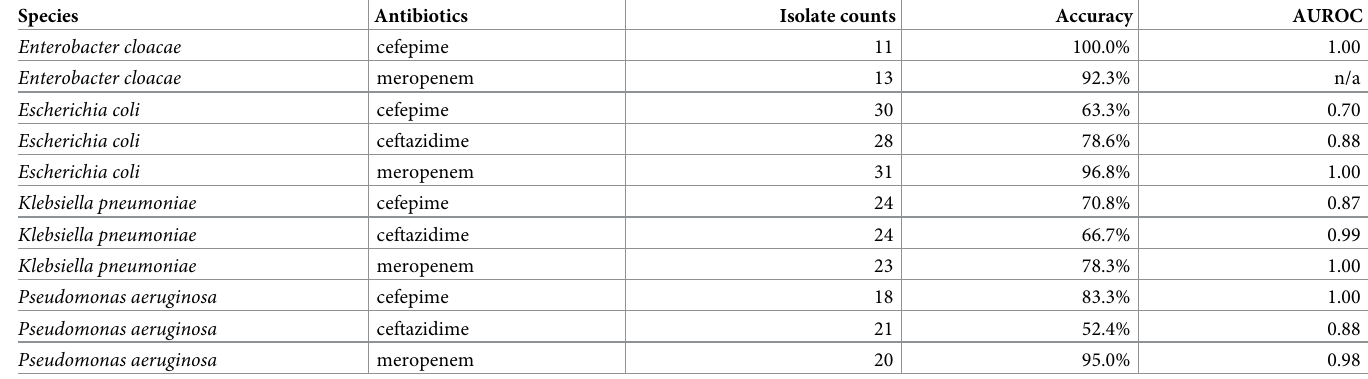
Table 2. External validation of VAMPr prediction model. The external dataset includes 13 Enterobacter cloacae , 31 Escherichia coli , 24 Klebsiella pneumoniae and 21 Pseudomonas aeruginosa isolates. All isolates were tested against 3 antibiotics (cefepime, ceftazidime and meropenem). We reported the accuracy as the fraction of correct predictions, and the AUROC (area under the receiver operator curve) represents the area under the operator-receiver characteristic. The AUROC value is n/a for E . cloacae as all 13 isolates are susceptible to